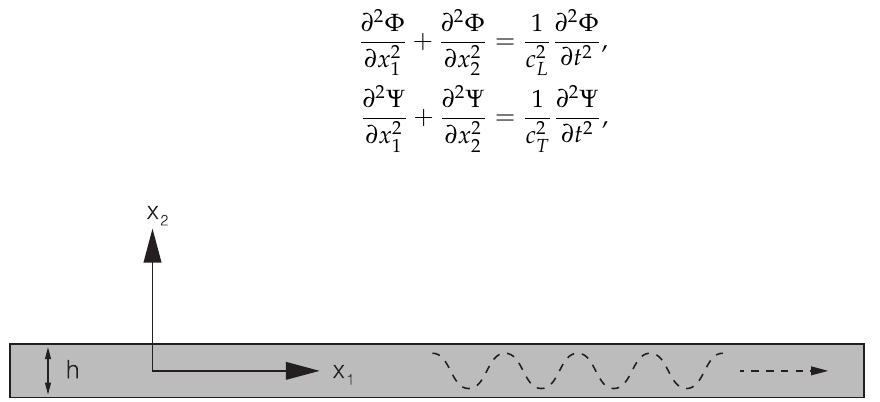
Figure 3. Geometry of the